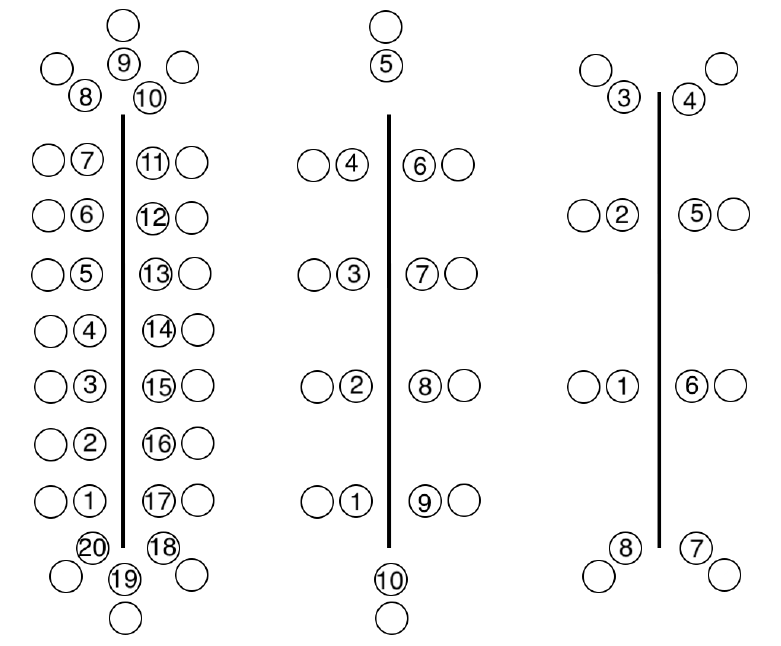
Figure A1. Participants walked on three 14-m walking paths with numbered markings at a distance of 20 cm, 40 cm, and 60 cm. Participants took right turns. The three inertial measurement units were placed at the low back and on top of the left and right feet. Elastic bands were used to hold the sensors in place. The depicted walking paths have fewer markings than the walking paths used for testing.